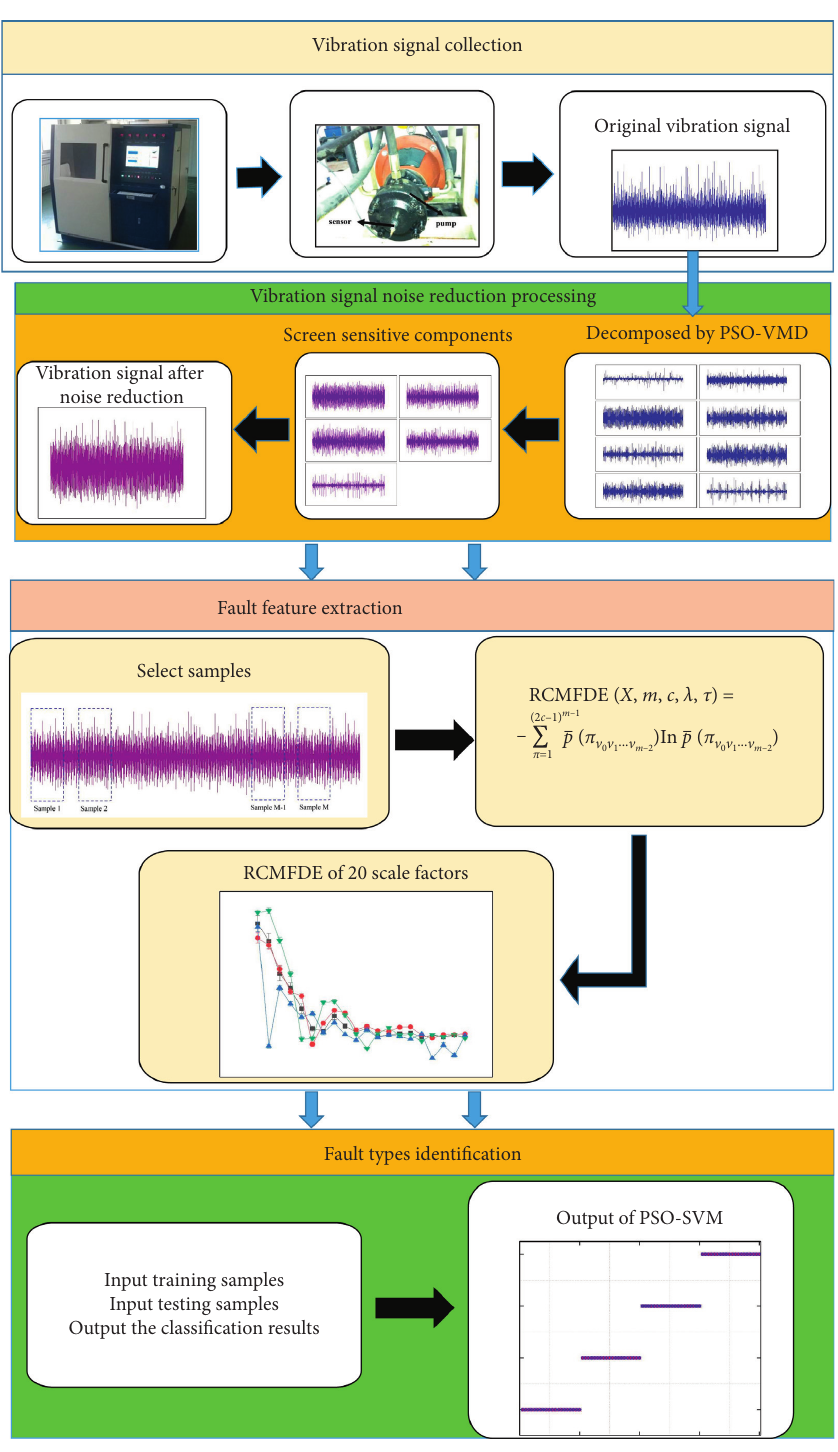
Figure 4: Flow chart of the proposed